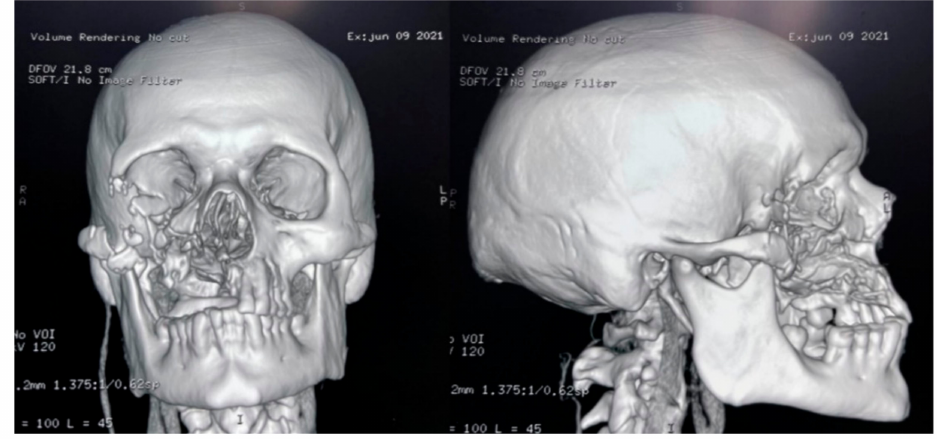
Figure 8. CT-scan of the head after the